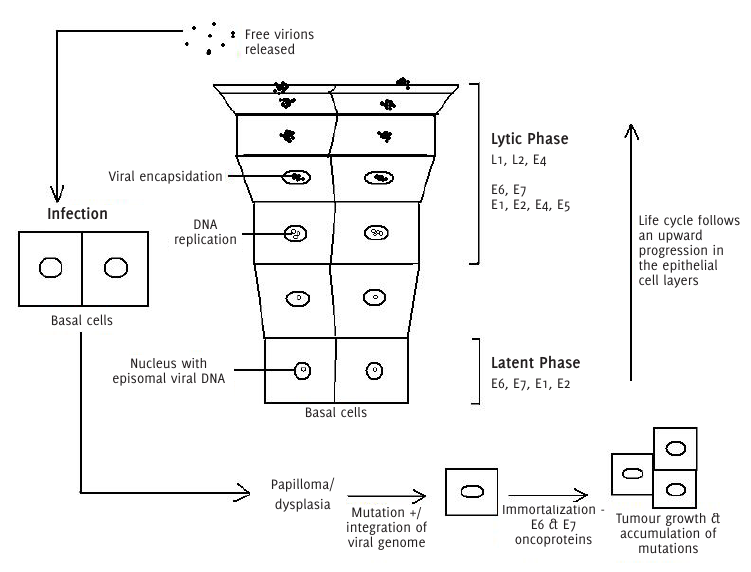
Figure 2. Life-cycle of the Human